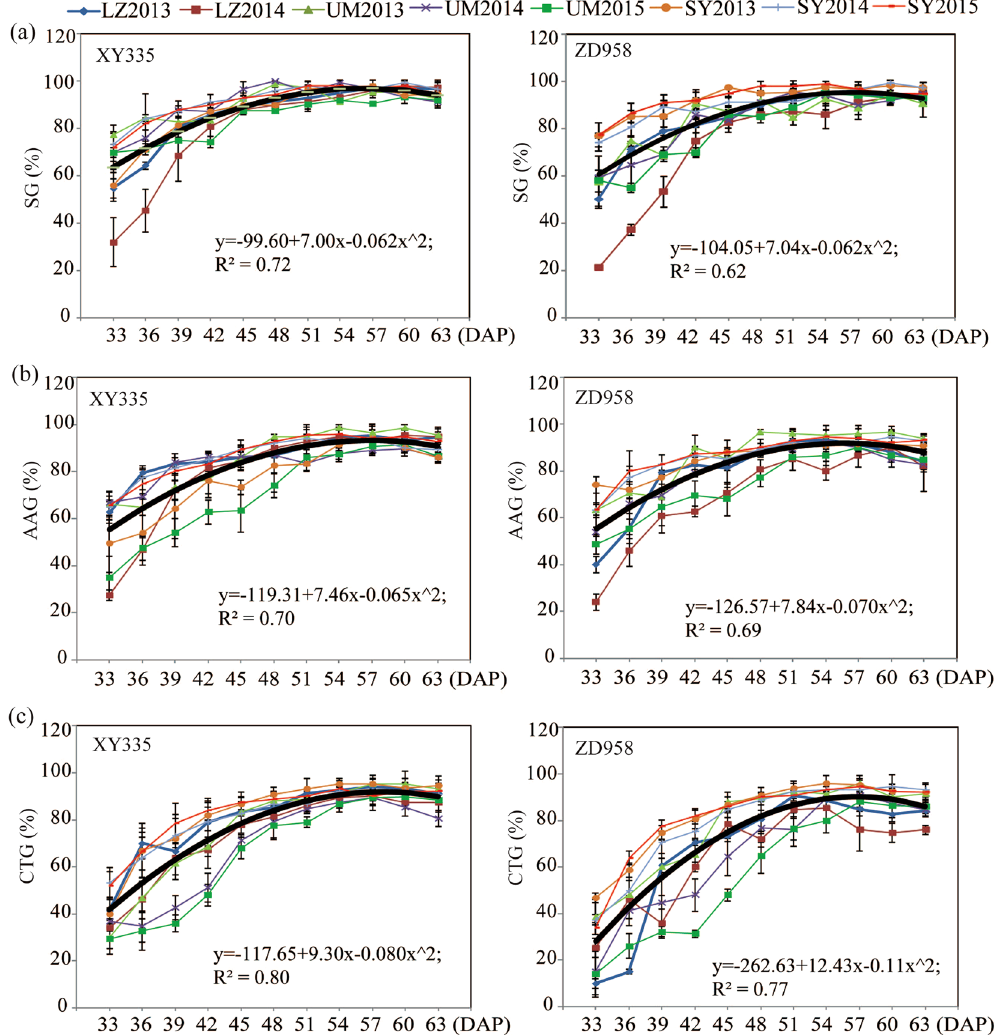
Figure 2. Performance of ( a ) standard germination (SG), ( b ) accelerated aging germination (AAG) and ( c ) cold test germination (CTG) in response to harvest stage in XY335 and ZD958 seeds grown in 3 locations (LZ, UM and SY) over 2–3 years (2013, 2014 and 2015). The relationship between harvest stage and the investigated traits was simulated using the “quadratic”, “linear” and “linear-plateau” models in the SAS program. The results from the best-fit model are presented by black lines and